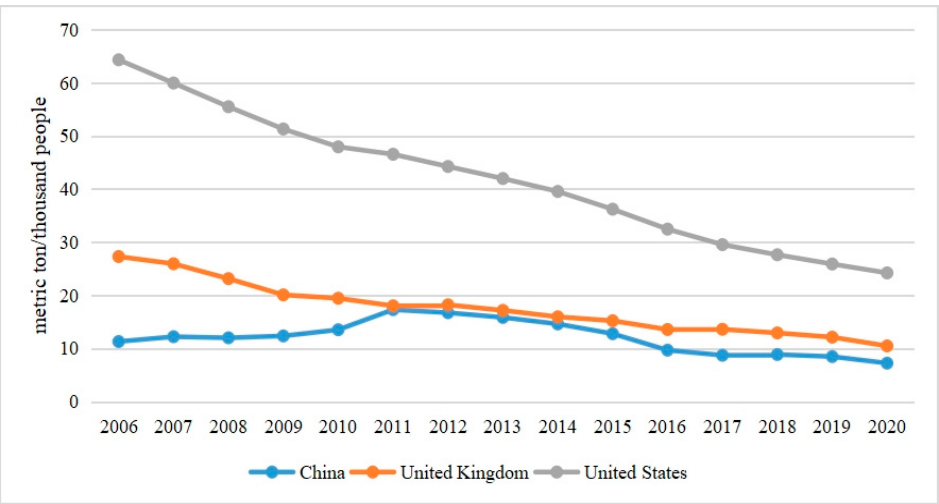
Figure1. 1990-2017 China, the UK, and the US Population-weighted average level of exposure to PM 2.5 (mean annual exposure (µg/m³)) Data source: World Bank/ourworldindata.org